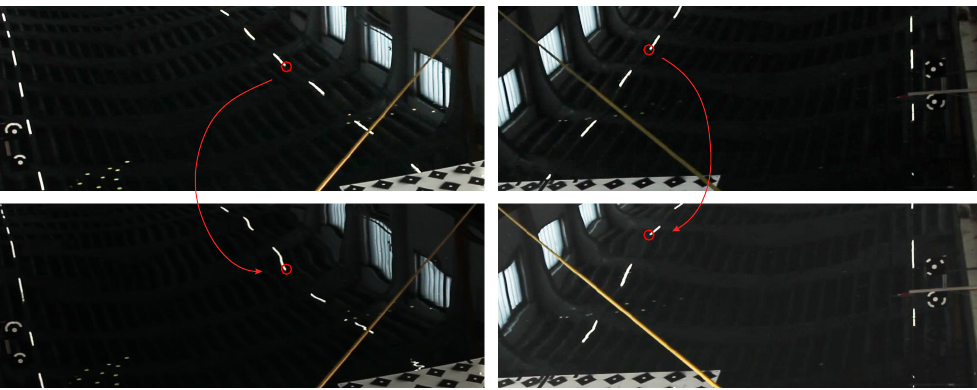
Figure 5. Specular reflections of the control information seen by two cameras. Top : calm water condition; the water can be considered a plane, and linear features map to linear reflections. Bottom : water in the excited condition; linear features map to deformed